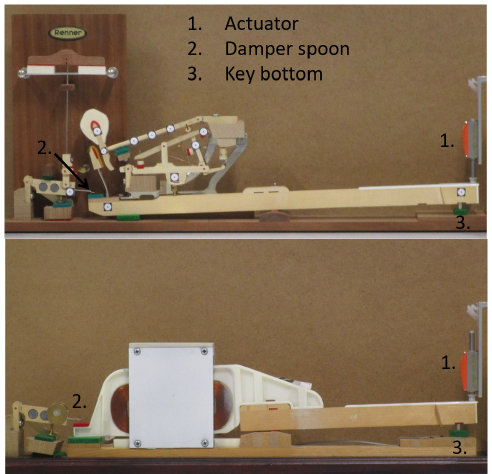
Figure 22. Measurements of the force felt by the pianist F haptic through an external linear actuator for the Renner R (cid:13) demonstrator ( up ) and the haptic prototype ( bottom